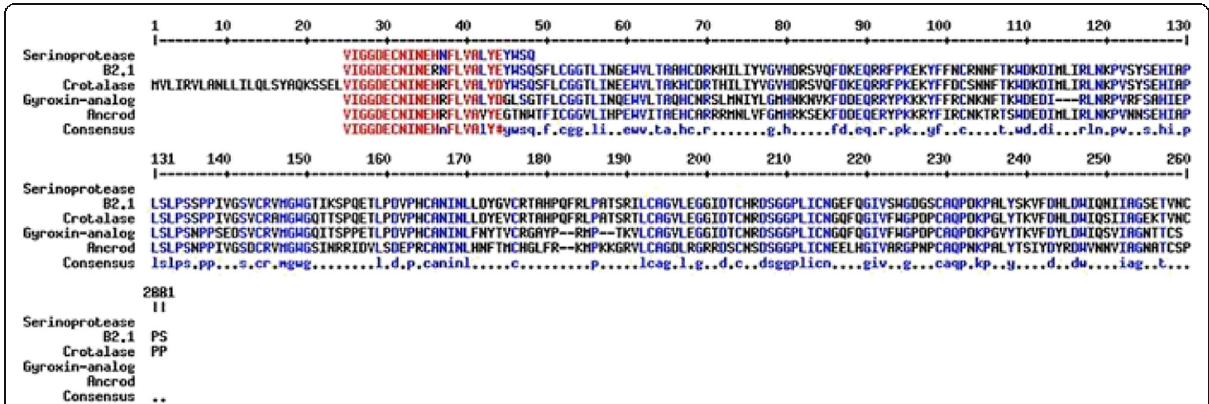
Fig. 6 Comparison between the N-terminal sequences by multiple alignment by MultiAlin program. The first sequence shows the serine protease purified in this study, followed by the sequences deposited in the NCBI such as: B2.1 (thrombin-like enzyme from Crotalus durissus terrificus venom); crotalase (thrombin-like enzyme from Crotalus adamanteus venom); gyroxin analog (thrombin-like enzye from Lachesis muta muta venom) and ancrod (thrombin-like enzyme from Agkistrodon rhodostoma ). The red letters indicate high similarity (90%) and blue a low similarity level (50%). The black letters indicate no